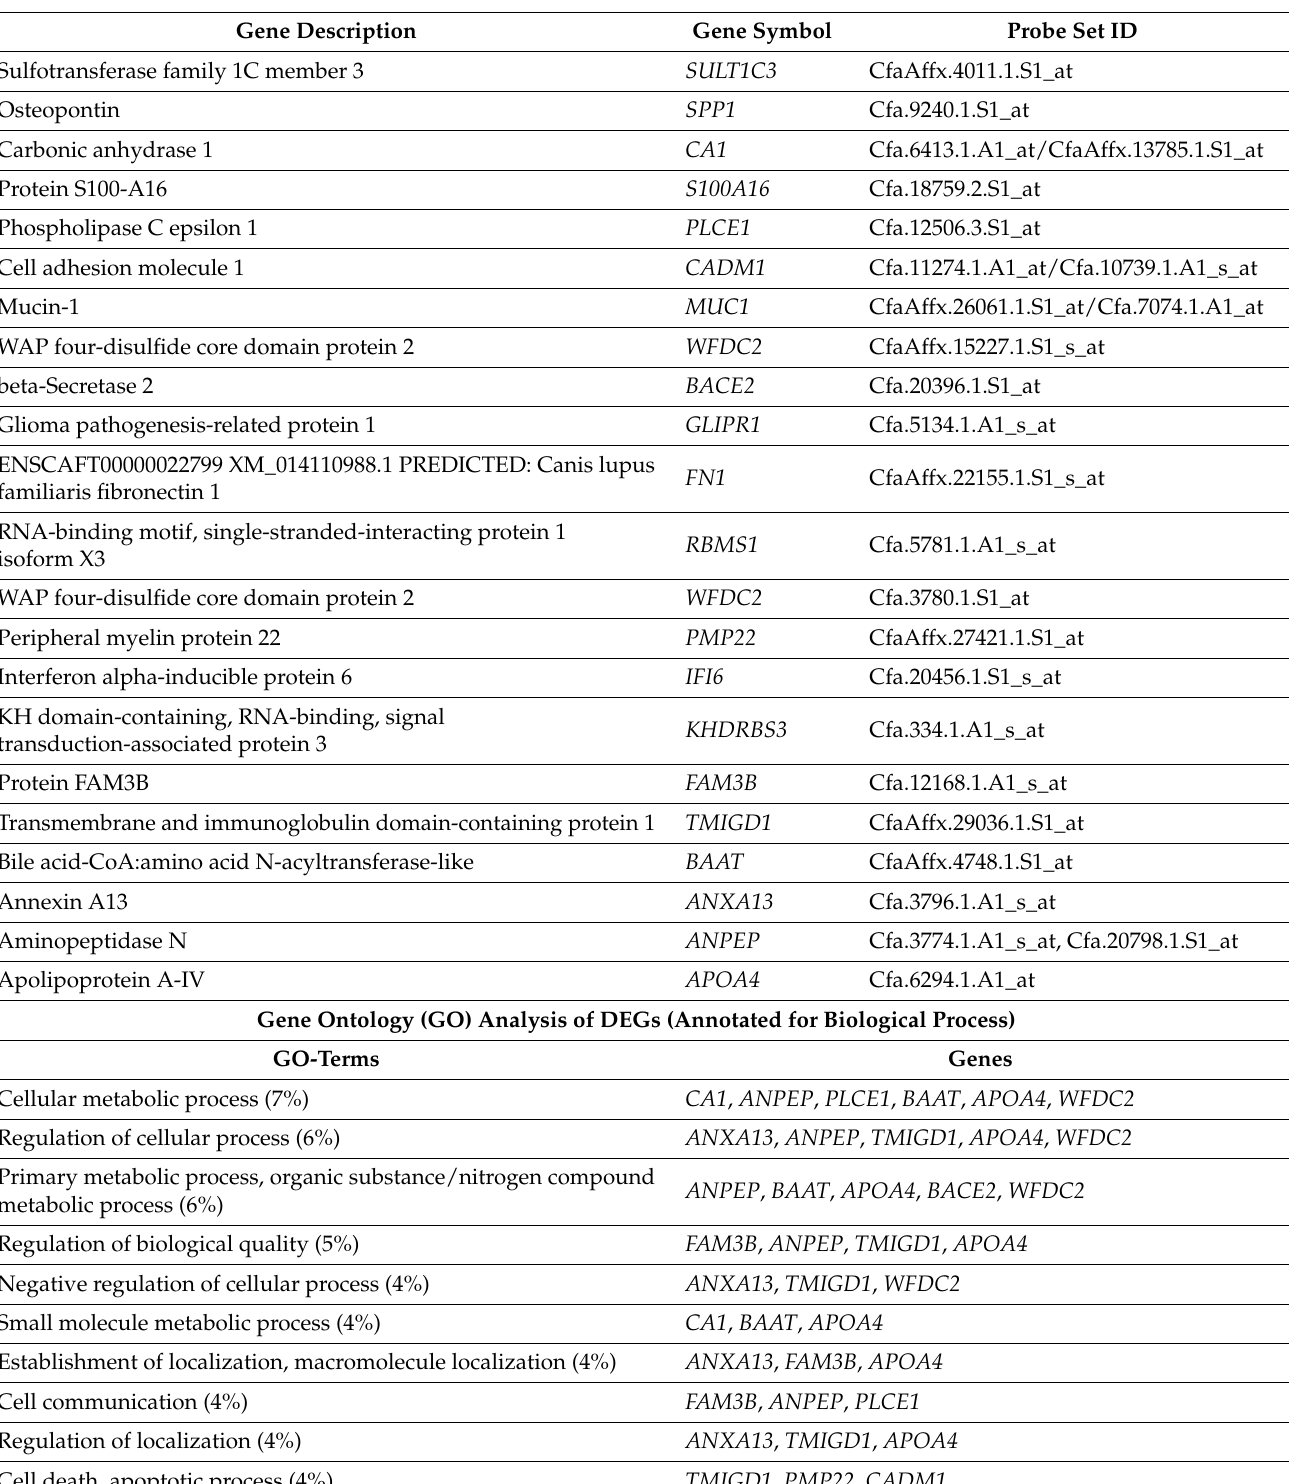
Table 7. The Gene Ontology (GO) analysis and details about the top 17 upregulated and six down- regulated DEGs in the control IBD colonoids vs. the control IBD enteroids. The DEGs annotated for biological process, molecular function, and cellular component categories are presented. The number of DEGs that fell into each of these categories is shown in